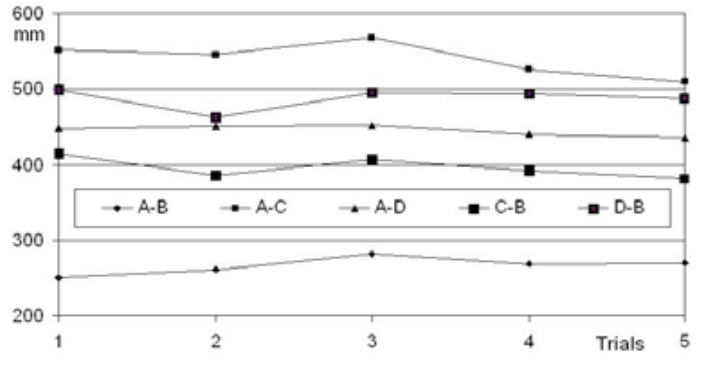
Figure 2 . Balance test-retest results vs. repeated trials. Table 4. Relative difference (left - lower, %) and significance (right - upper) Feet